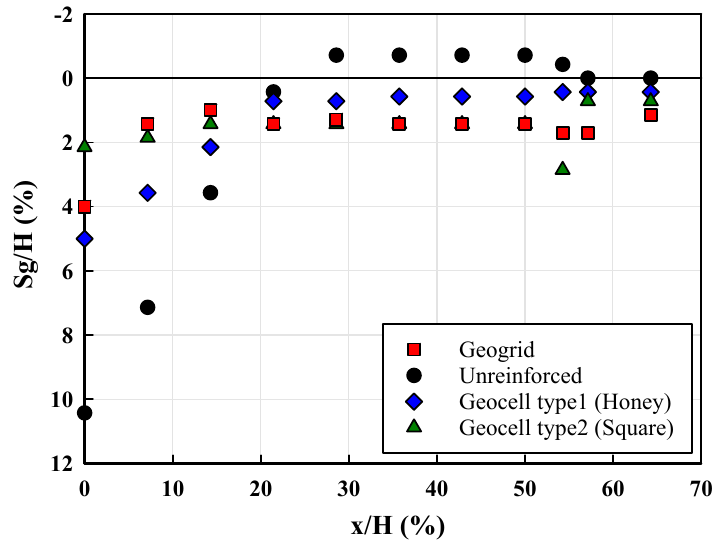
Figure 17. Settlements near the abutment after 120 cycles.